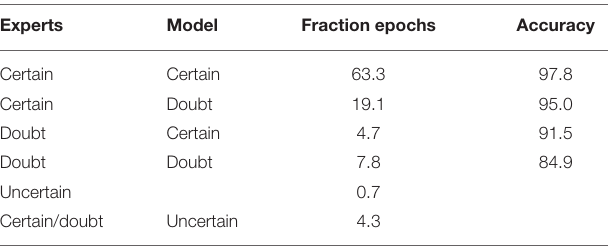
algorithm predicts no transition to N3. All experts agree that both TABLE 5 | Accuracy and fraction of epoch per